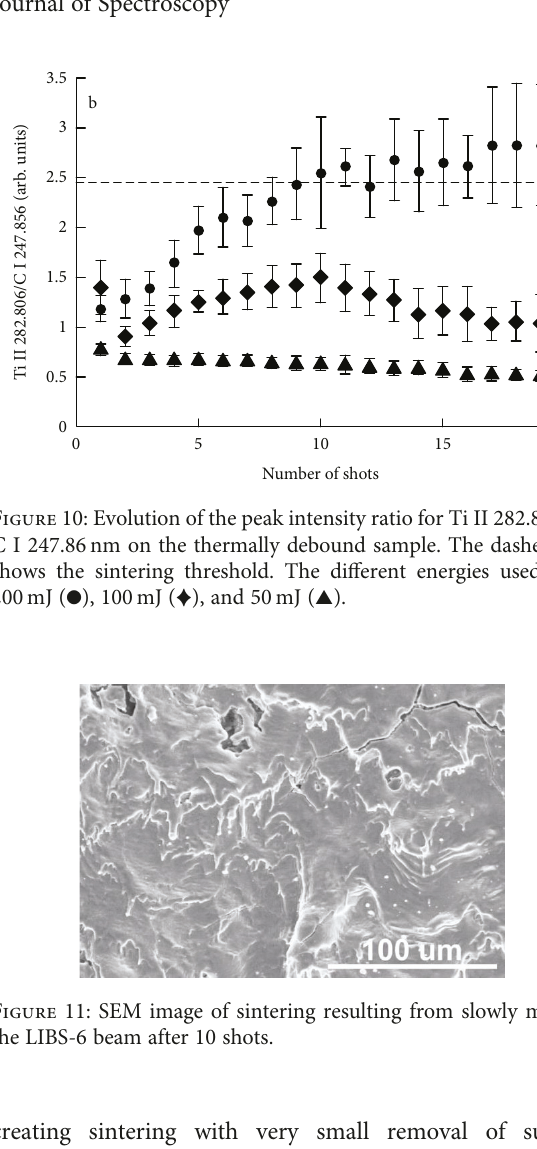
Table 3: Sample composition after repetitive shots compared to traditional sintering. Results obtained from EDS. C (Wt.%) Ti (Wt.%) V (Wt.%) Si (Wt.%)